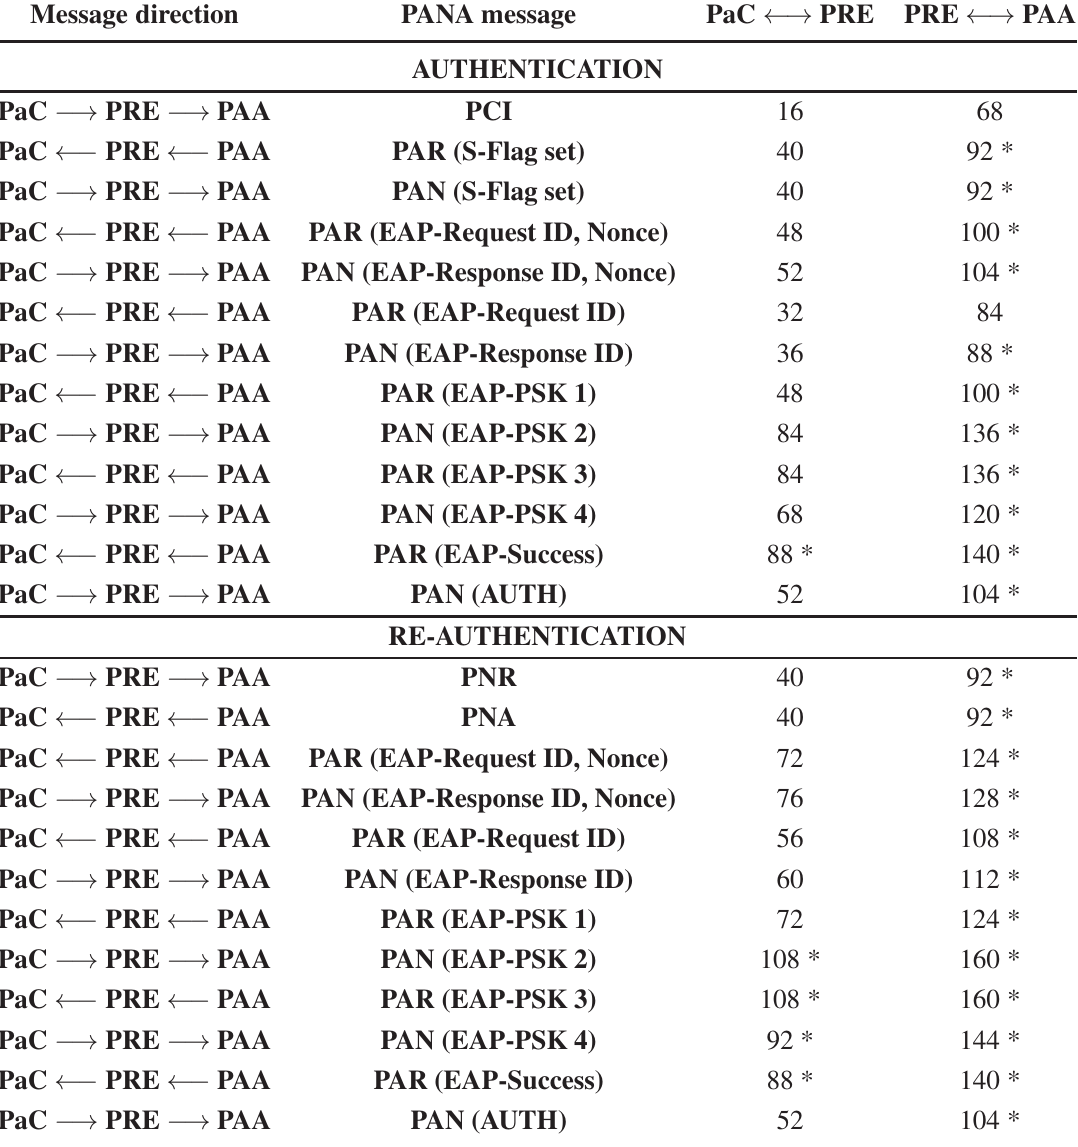
Table 2. PANA message length. PaC, PANA Client; PRE, PANA Relay; PAA, PANA Authentication Agent; PAN, PANA Answer; PAR, PANA-Auth-Request (PAR); PNR,